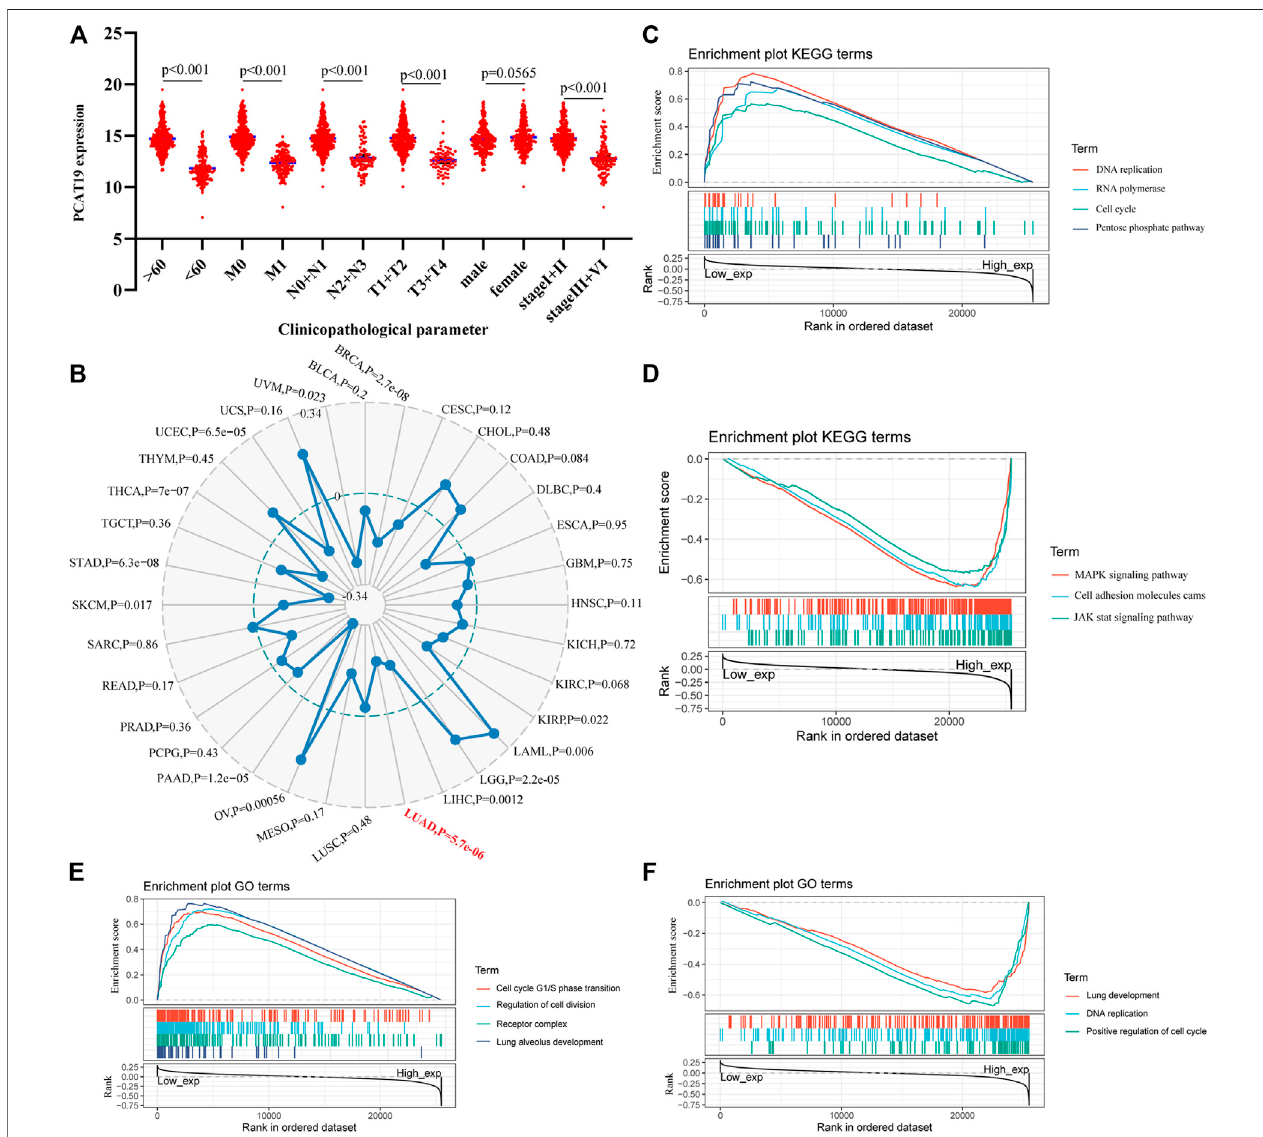
FIGURE 5 | (A) Correlation analysis of the expression of PCAT19 with clinicopathological parameters of lung adenocarcinoma. (B) Radar chart shows the correlation between the expression of PCAT19 and the tumor mutational burden of each tumor. The red font represents lung adenocarcinoma; (C,D) KEGG pathway analysisshowed (C) positivelycorrelatedgroupsand (D) negativelycorrelatedgroups; (E,F) GOtermanalysisrevealed (E) positivelycorrelatedgroupsand (F) negatively correlated groups.